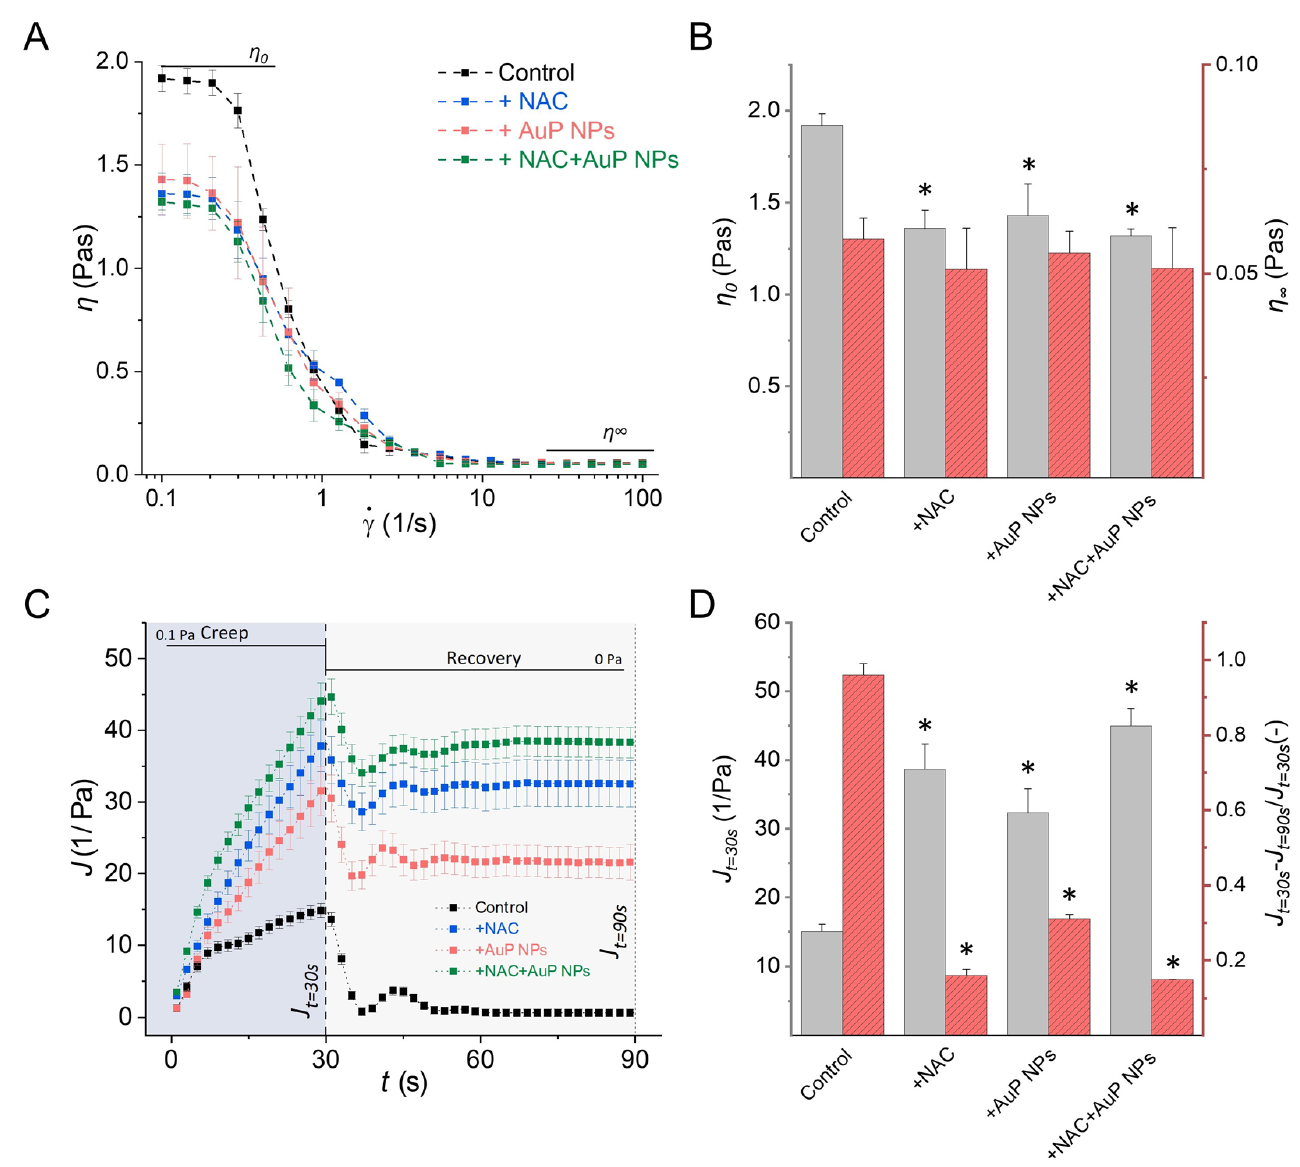
Figure 4. Rheological properties of Pseudomonas aeruginosa biofilm under the influence of N-acetyl- cysteine (NAC) and peanut-shaped gold nanoparticles (AuP NPs): ( A ) dynamic viscosity as a function of shear rate for control samples, and samples treated with tested compounds; ( B ) zero-shear viscosity η 0 and infinity-shear viscosity η ∞ determined from the viscosity curves; ( C ) compliance as a function of time in creep-recovery tests; ( D ) mean maximal creep compliance values (at 30 s Jt = 30 s) and the ratio of difference between Jt = 30 s and unrecovered creep compliance (at 90 s Jt = 90 s) to maximal creep compliance calculated from creep-recovery curves. * indicates statistical significance ( p < 0.05) compared to untreated control. Infection and Drug Resistance 2022:15 851-871. Originally published by and used with permission from Dove Medical Press Ltd. [121] .